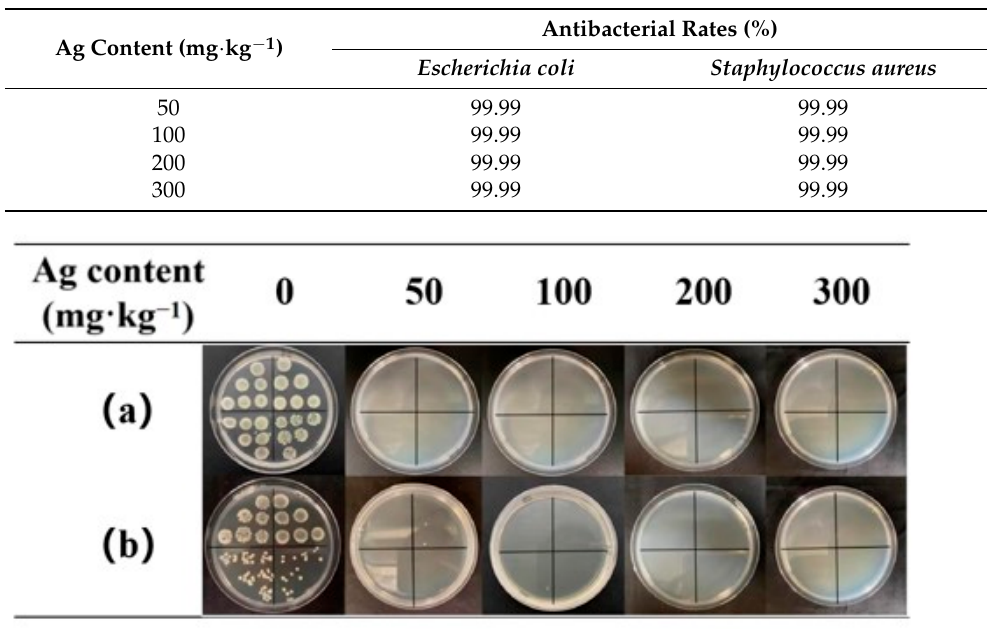
Figure 6. Petri dishes containing ( a ) E. coli and ( b ) S. aureus with TPU nanofiber membrane samples with Ag content ranging from 0 mg·kg −1 to 300 mg·kg −1 after 50 times of chlorine washing.